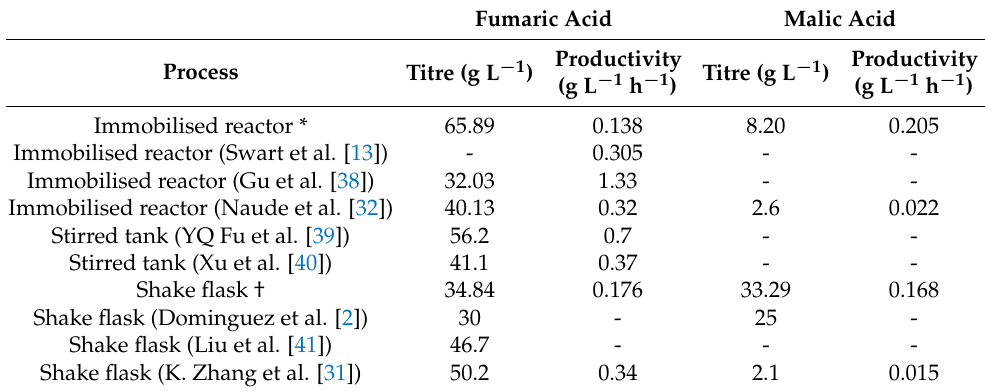
Table 2. Comparison of fumaric acid and malic acid production using R. delemar